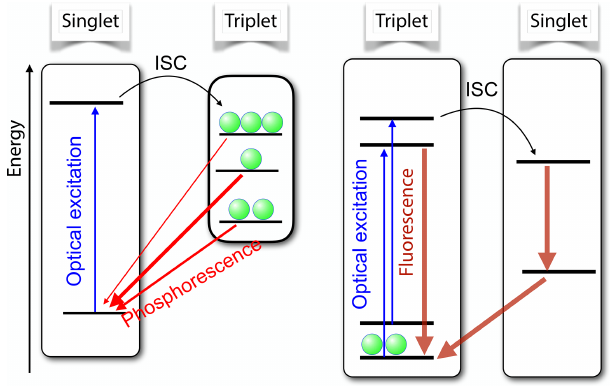
Figure 5. Basic principle of spin-selective intersystem crossing (ISC) for the case of a singlet ground state (left) and a triplet ground state (right). In both cases, the optical irradiation results in unequal populations of the triplet